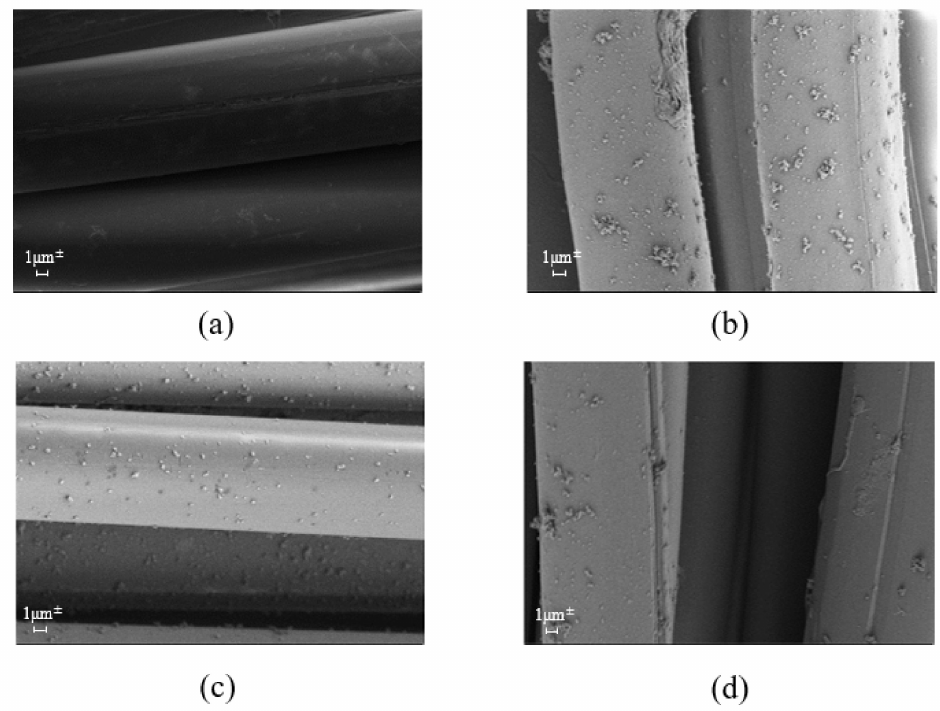
Figure 11. ZnCl 2 -treated 6 h SEM image on the surface of the fiber. ( a ) 6 wt% ZnCl 2 , ( b ) 6 wt% ZnCl 2 PDA, ( c ) 6 wt% PDA ZnCl 2 and ( d ) 10 wt% ZnCl 2